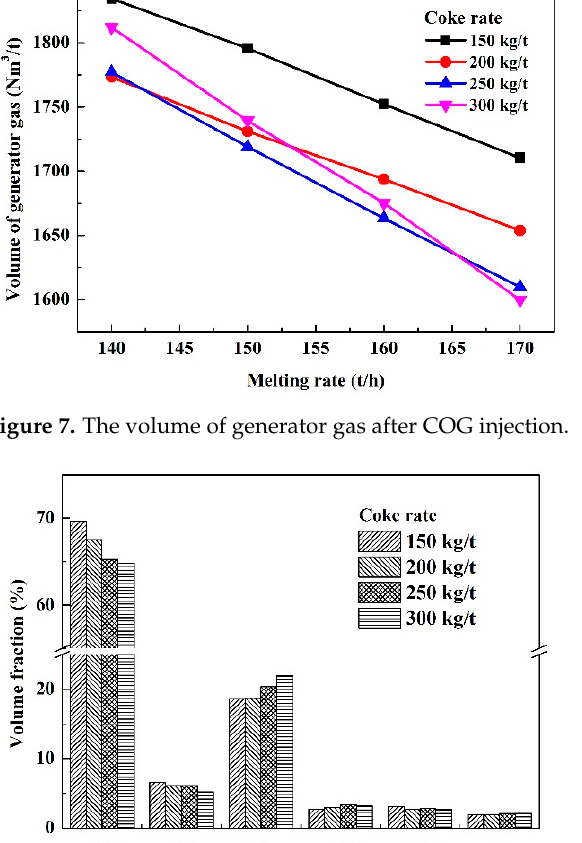
Figure 7. The volume of generator gas after COG injection.